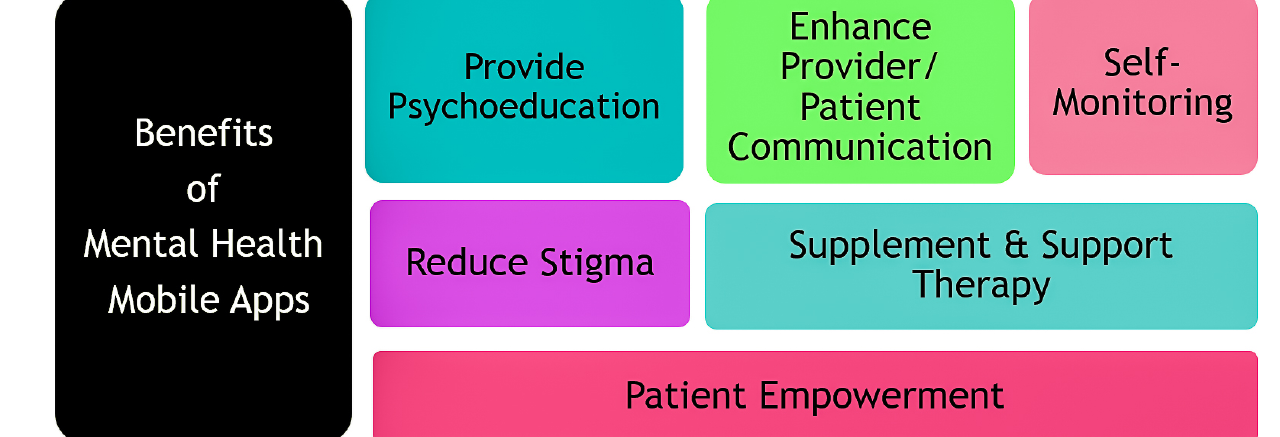
Figure 5. Benefits and uses of mental health mobile